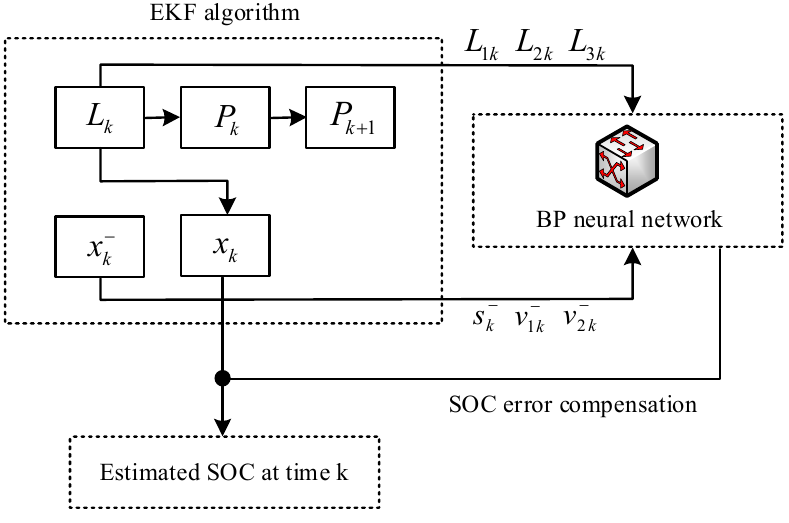
Figure 3. Structure of BP-EKF model.